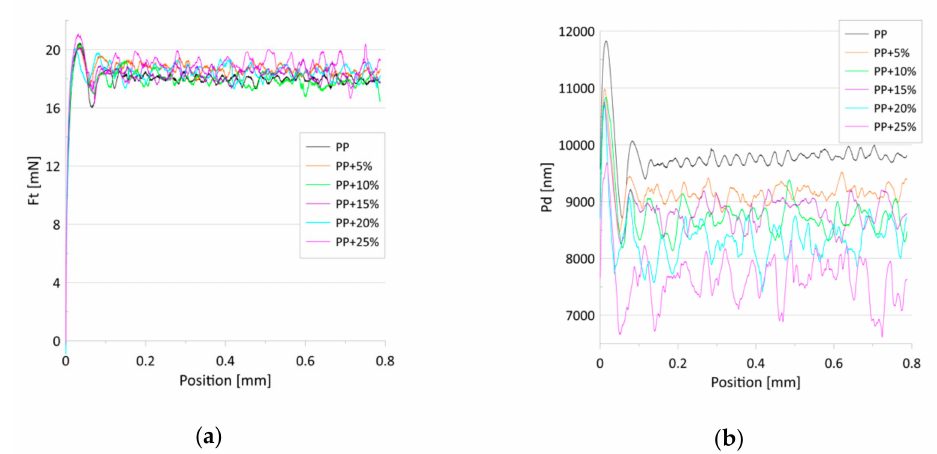
Figure 6. ( a ) The average dependence of the friction force (Ft) on the scratch positions for the tested samples; ( b ) The average dependence of the penetration depth (Pd) on the scratch position for the tested samples. The constant load was 20